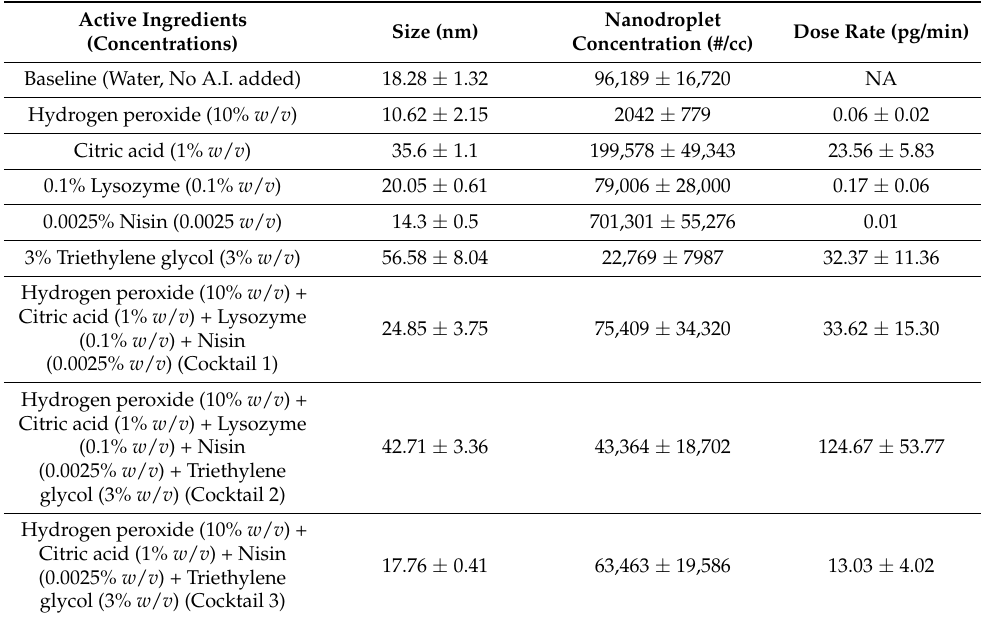
Nanodroplet Size (nm) Dose Rate (pg/min) Concentration (#/cc)